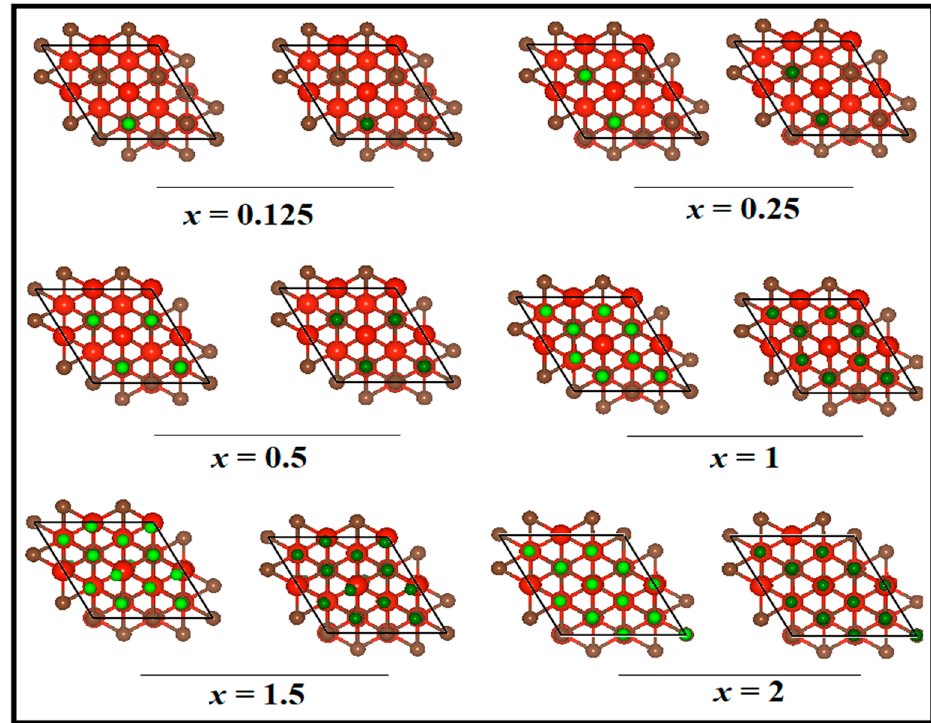
Figure 2. Front views of optimized structures of Li x V 4 C 3 and Na x V 4 C 3 at x = 0.125, 0.25, 0.5, 1, 1.5, and 2. The red color balls are V, brown ones are C, green ones are Li, and dark green ones are Na.